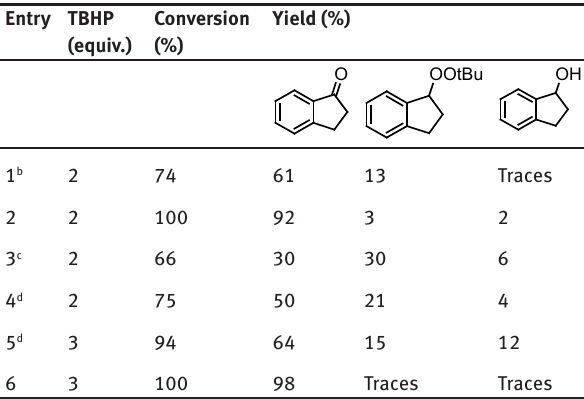
Table 1 : Oxidation of indane ( 1 ) with aqueous 70%TBHP catalyzed by CuCl .2H O/BQC. 2 2